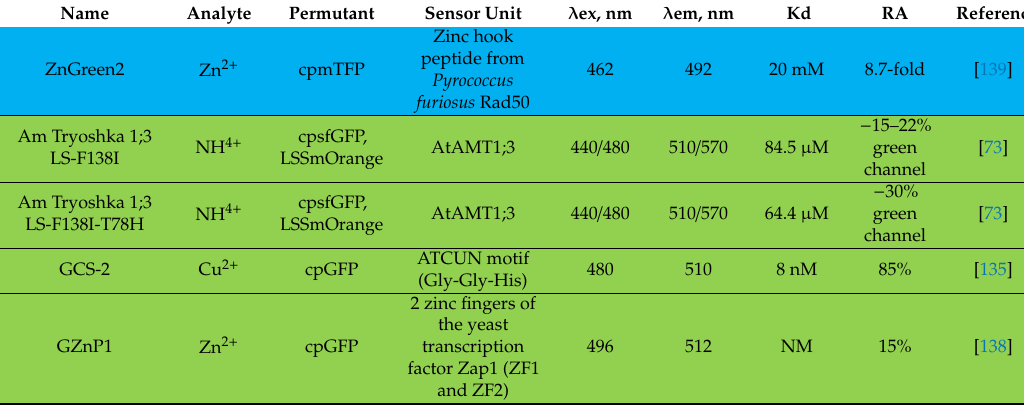
Table 2. GEFIs for inorganic ions